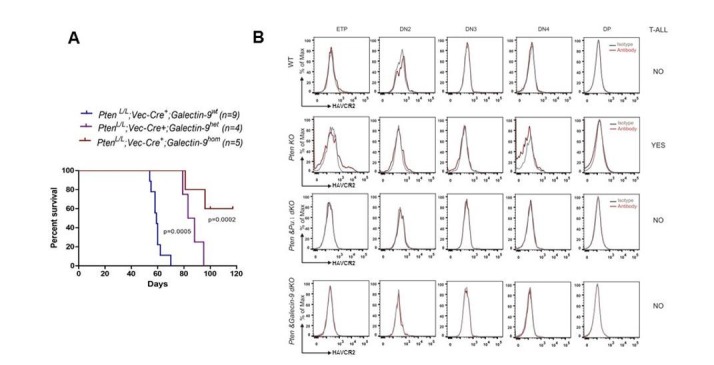
Gal-9 is essential for the Pten null T-ALL LSC formation and leukemia development.(A). Deletion of the HAVCR2 ligand Gal-9 delays or prevents the Pten null T-ALL development in vivo. (B). HAVCR2high LSCs at ETP stage in the Pten null T-ALL are eliminated by SPI1 or Gal-9 deletion in vivo.